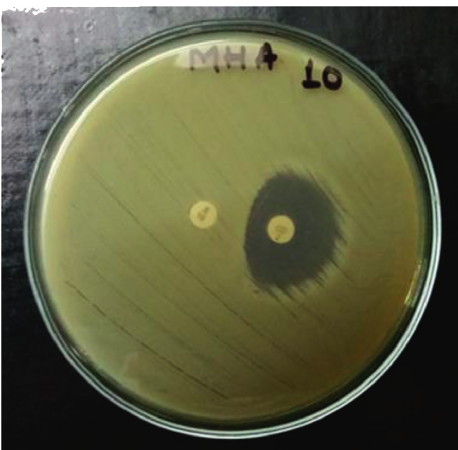
Figure 3: Inducible clindamycin resistant (D-test) (isolate no. 10).